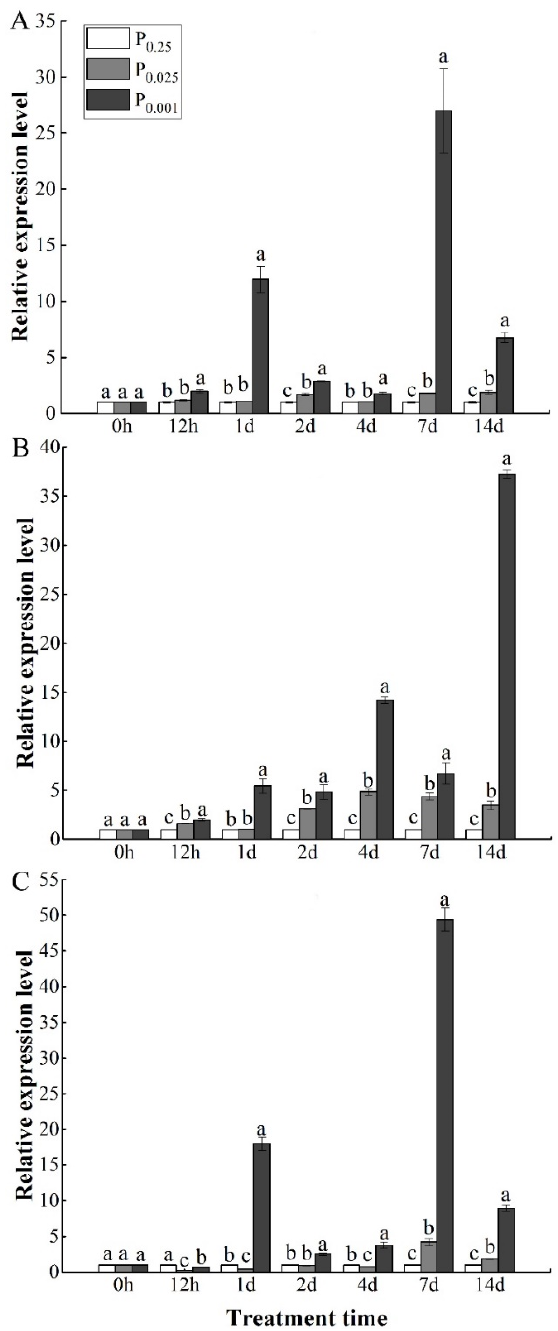
Figure 4. Relative expression level of the PHT1 family genes PHT1;3 ( A ), PHT1;4 ( B ), and PHT1;7 ( C ) in melon roots under low ‐ Pi stress. The error bars indicate the SD ( n = 6). The lowercase letters indicate the significant differences in the parameter, at the same treatment time, among the treatments using one ‐ way ANOVA with Tukey’s test ( p < 0.05).